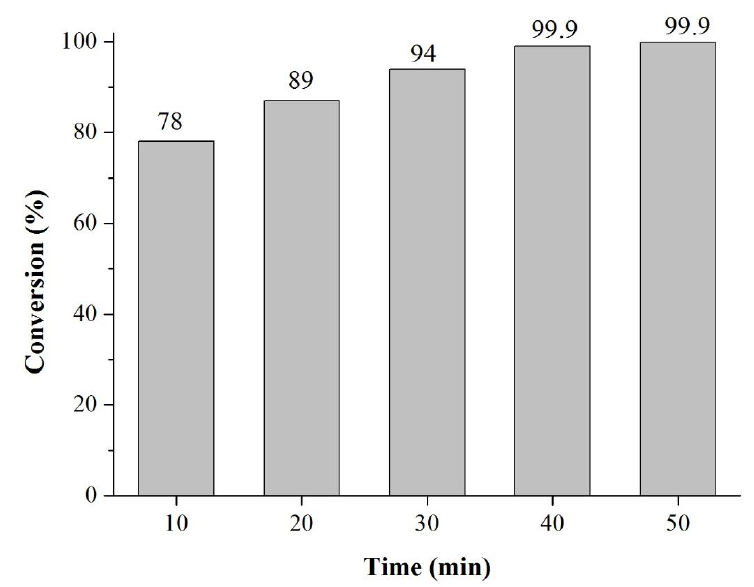
Figure 9. Percentage conversions of eugenyl acetate varying the reaction time. Reaction conditions: eugenol: acetic anhydride (1:5), reaction temperature 80 °C and 2% catalyst.